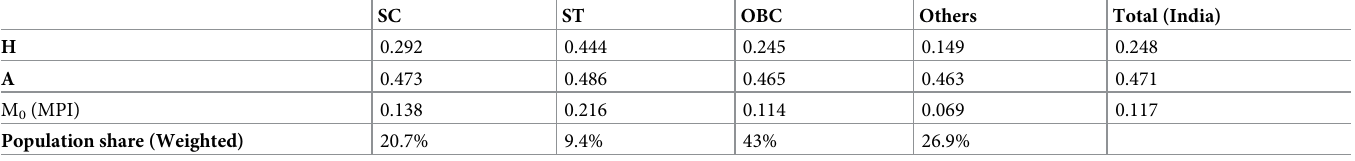
Table 3. Multidimensional poverty estimates for the social groups in